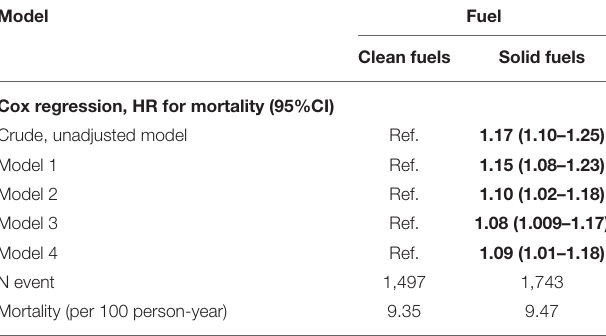
TABLE 2 | Association of cooking fuels with mortality. Model